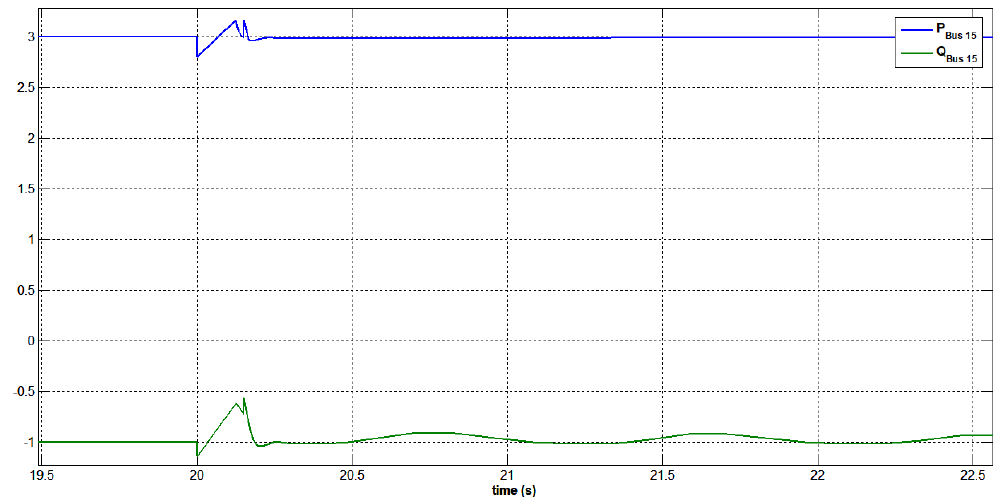
Figure 52. Generated active and reactive power at bus 15 after a three-phase short circuit at bus 3 with STATCOM.